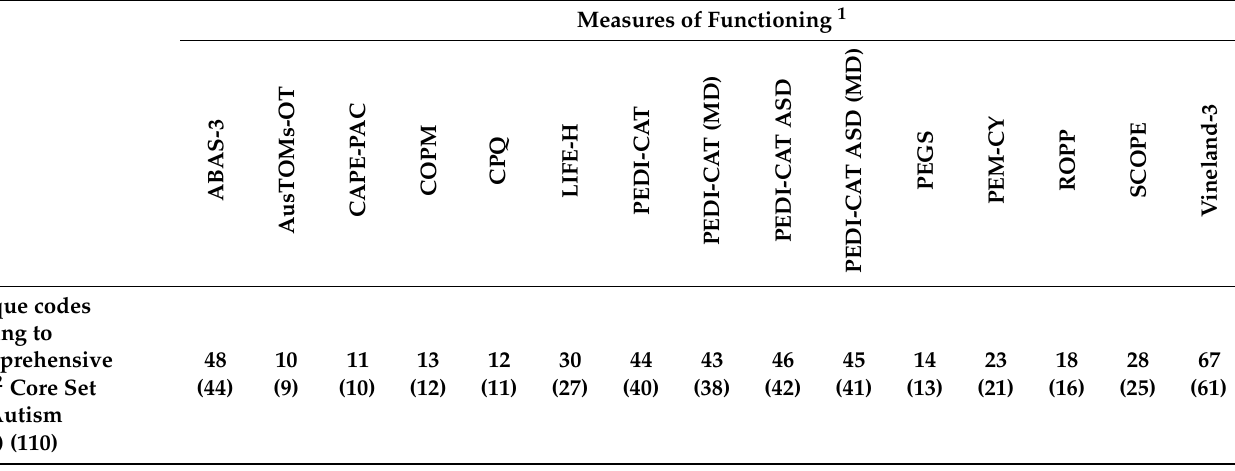
Table 7. Percentage of unique codes linking to the International Classification of Functioning, Disability and Health Core Sets [20] for Autism covered by measures of